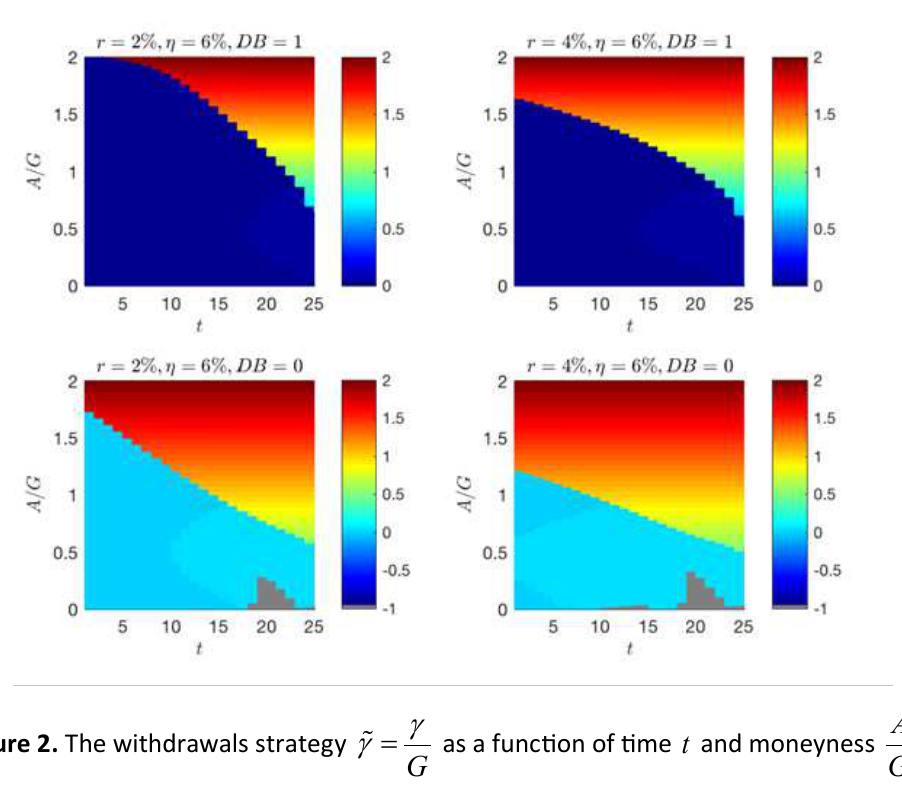
Figure 2. The withdrawals strategy